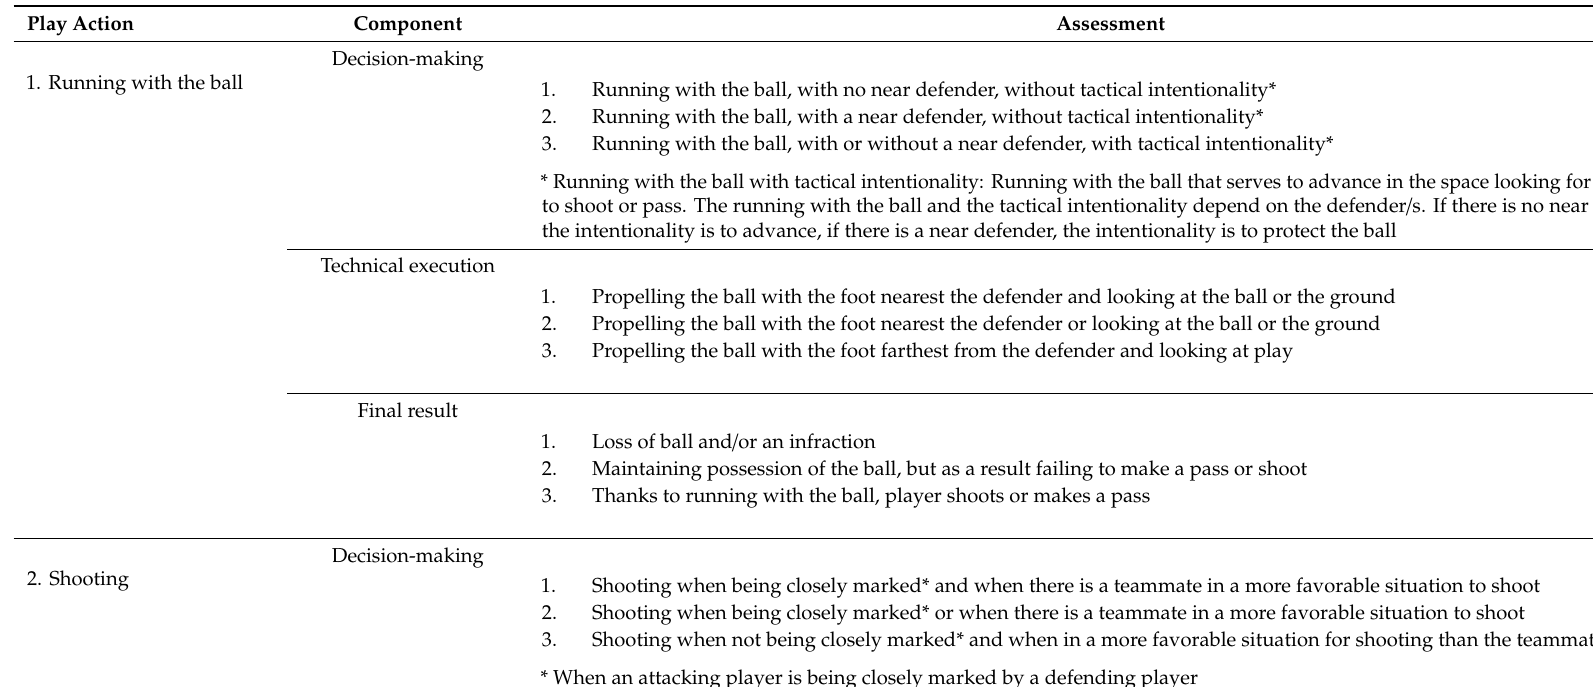
Table A1. Instrument for the measurement of learning and performance in football